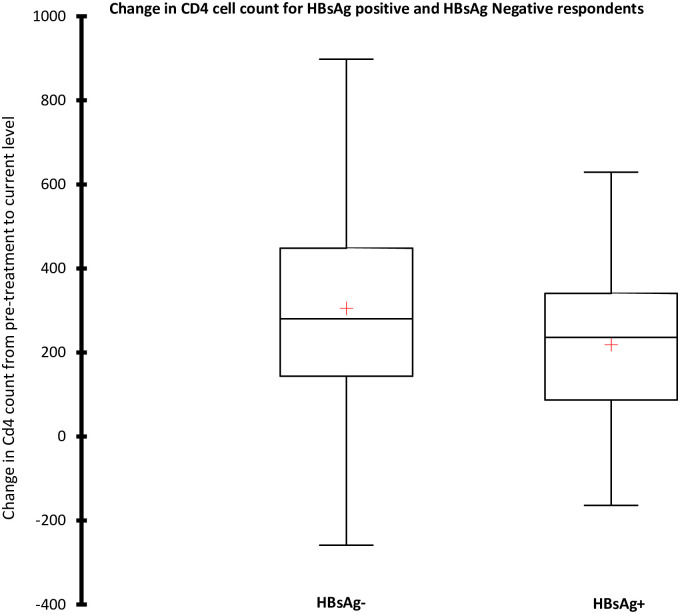
Box plot showing the change in CD4+ T cell count from pre-ART initiation level to the most recent in HBsAg positive and negative patients.